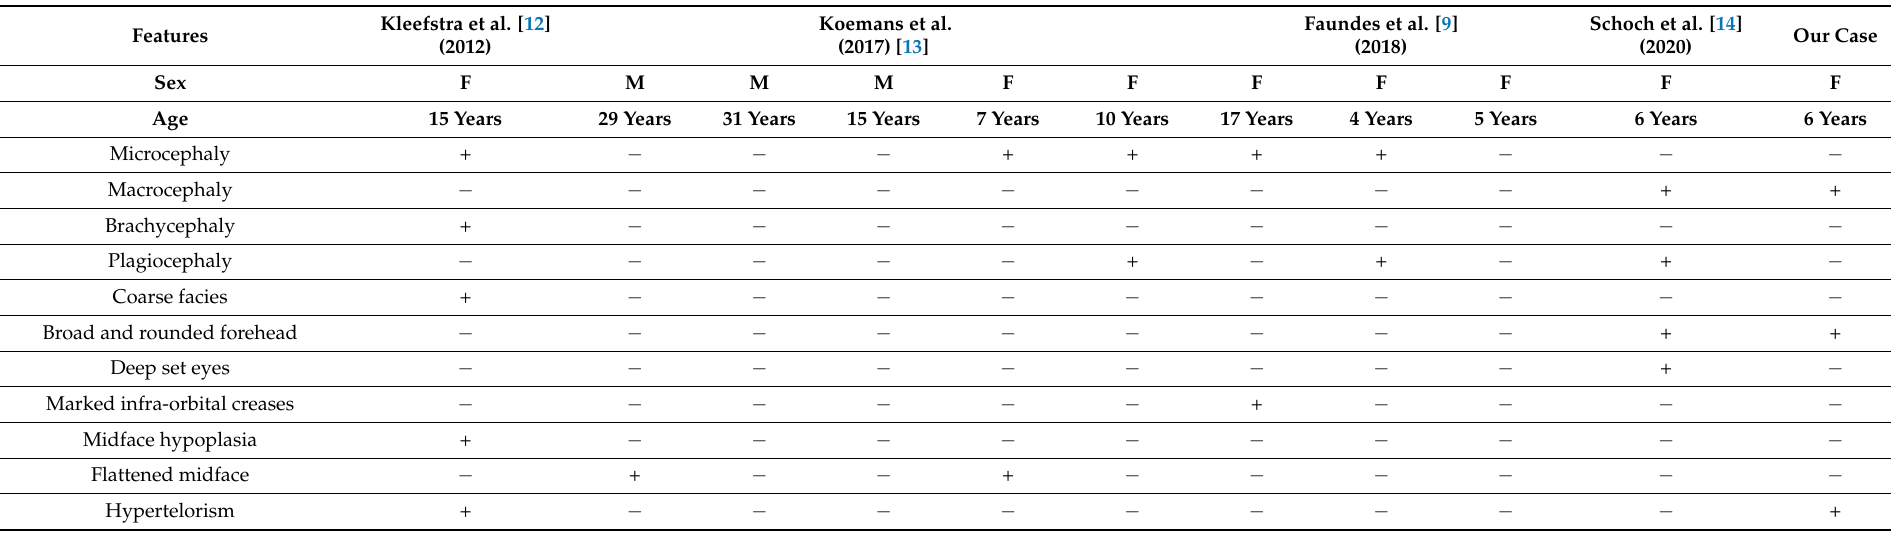
Table 2. Facial dysmorphisms and other physical characteristics of affected individuals with KMT2C